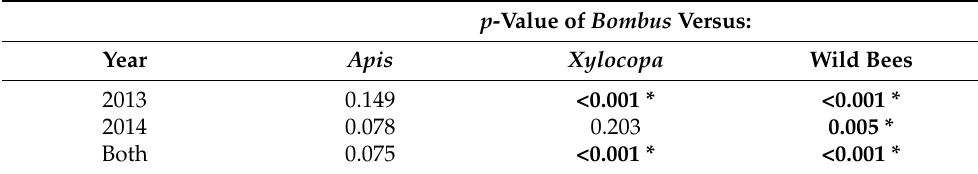
Figure 6. Flower visitation of bees from each category as a function of the ambient temperature ( A ) on pollen-providing flowers and ( B ) on nectar-providing flowers. The vertical axis presents the cumulative frequency of bee numbers recorded during 2013 and 2014. Table 6. Visitation records on all flowers: Bumblebees compared to bees from each of the three other categories as a function of ambient temperature.